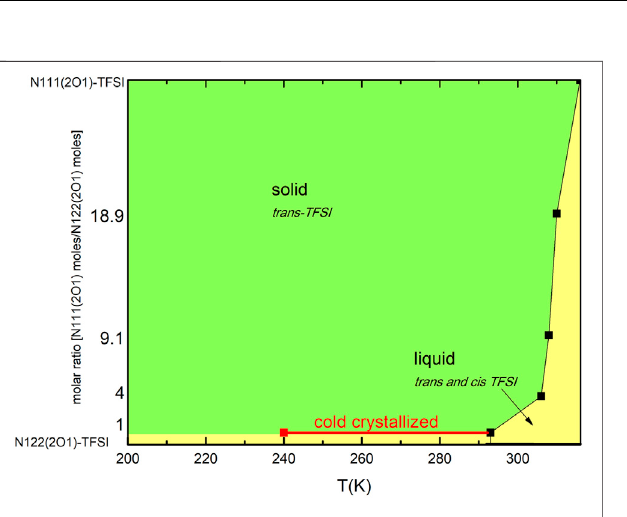
Frontiers in Physics |